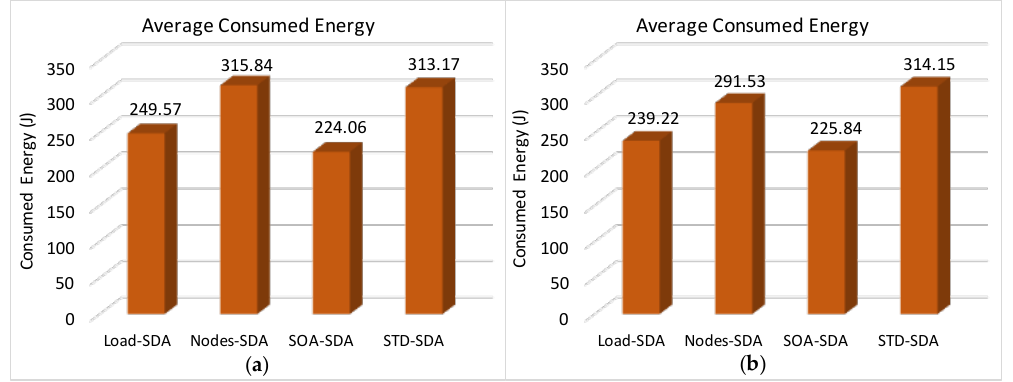
Figure 20. Average consumed energy for the allocation schemes: ( a ) Unconditioned Scenario; ( b ) Conditioned Scenario.